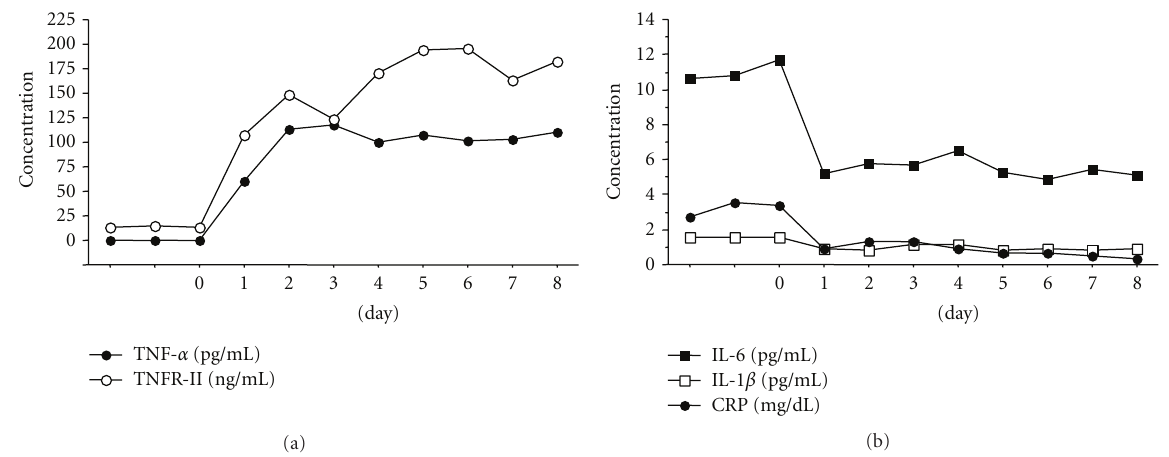
Figure 2: Time course of serum cytokines concentrations from baseline to 8 days. (a) TNF- alpha was not detectable in baseline samples. One day after the start of etanercept therapy TNF- alpha was measurable by ELISA. TNF- alpha levels became steady within 2 days of etanercept therapy. TNFR-II concentrations became elevated after the start of etanercept therapy. Within the first week of etanercept therapy, TNFR- II reached levels ranging from 160 ng/mL to 190 ng/mL. (b) Serum IL-6, IL-1 beta, and CRP concentrations were decreased just after the initiation of treatment.